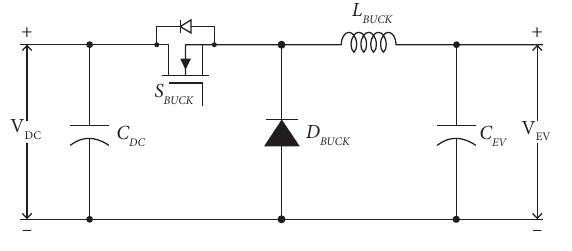
Figure 3: Te buck converter diagram.